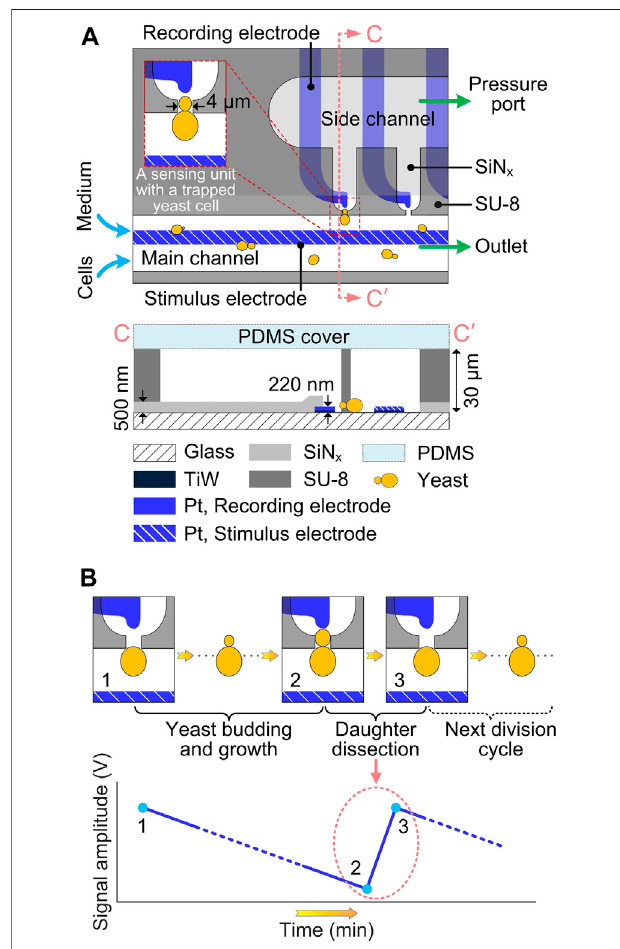
FIGURE 1 | Schematics of EIS-biosensor-integrated microdevice for real-time monitoring of single budding yeast cells. (A) Top view and Cross- sectional view along CC ′ in the impedance sensing area of the micro fl uidic device. Insert shows the impedance sensing unit with an immobilized budding yeast cell. For better illustration, dimensions are not to scale. (B) In- situ sensing principle of the yeast dissection event using the electrical impedance biosensor. The instantaneous detachment of daughter cell results in a drastic increase (from 2 to 3) of EIS signal